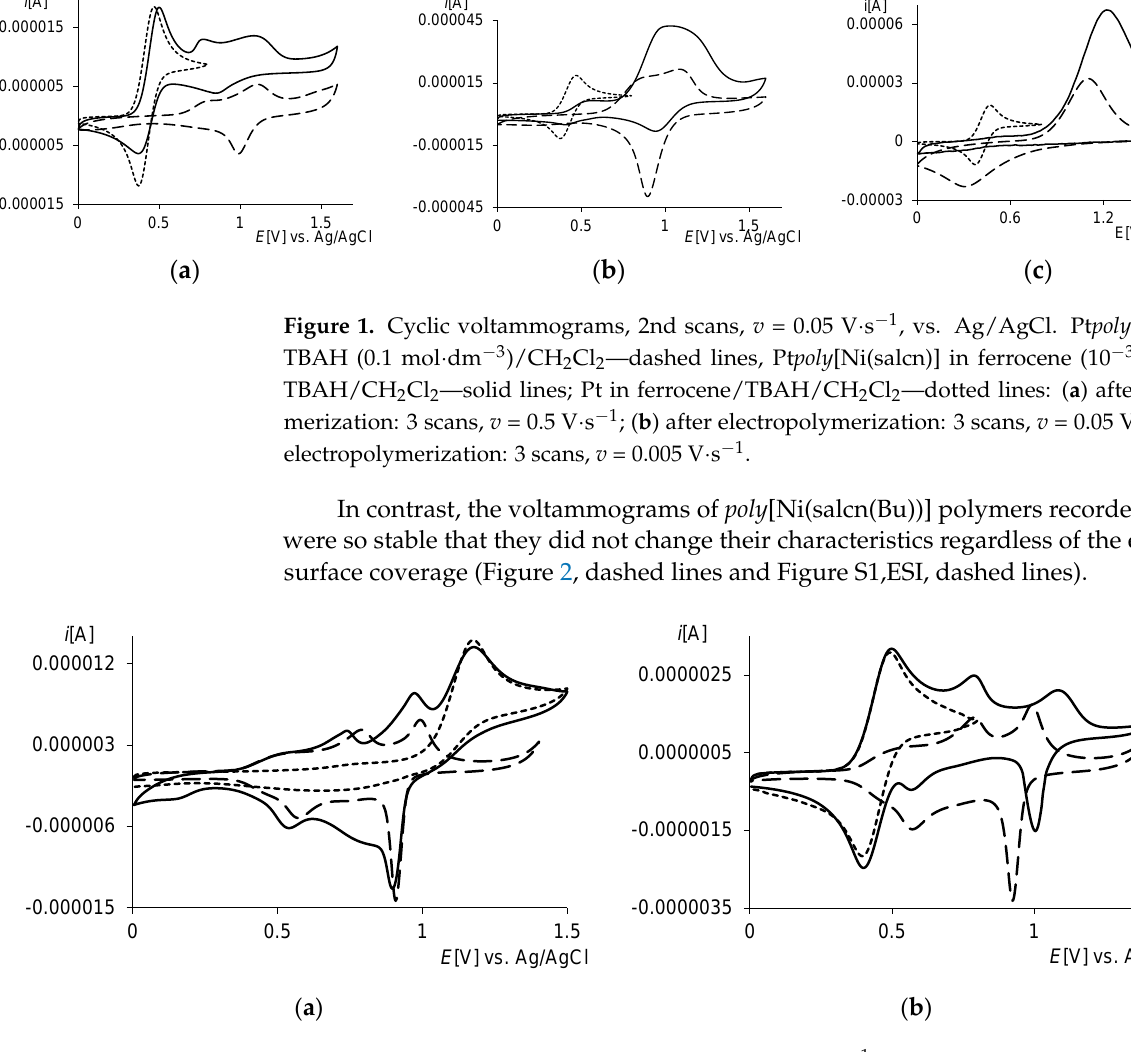
Figure 2. Cyclic voltammograms, 2nd scans, v = 0.05 V · s − 1 , vs. Ag/AgCl. ( a ) Pt poly [Ni(salcn(Bu))] in TBAH (0.1 mol · dm − 3 )/CH 2 Cl 2 (after electropolymerization: 3 scans, v = 0.05 V · s − 1 )—dashed line; Pt poly [Ni(salcn(Bu))] in catechol(10 − 3 mol · dm − 3 )/TBAH/CH 2 Cl 2 —solid line; Pt in catechol/TBAH/CH 2 Cl 2- dotted line. ( b ) Pt poly [Ni(salcn(Bu))] in TBAH (0.1 mol · dm − 3 )/CH 2 Cl 2 (after electropolymerization: 1 scan, v = 0.05 V · s − 1 )—dashed line, Pt poly [Ni(salcn(Bu))] in ferrocene (2 × 10 − 4 mol · dm − 3 )/TBAH/CH 2 Cl 2 —solid line; Pt in ferrocene/TBAH/CH 2 Cl 2 —dotted line.